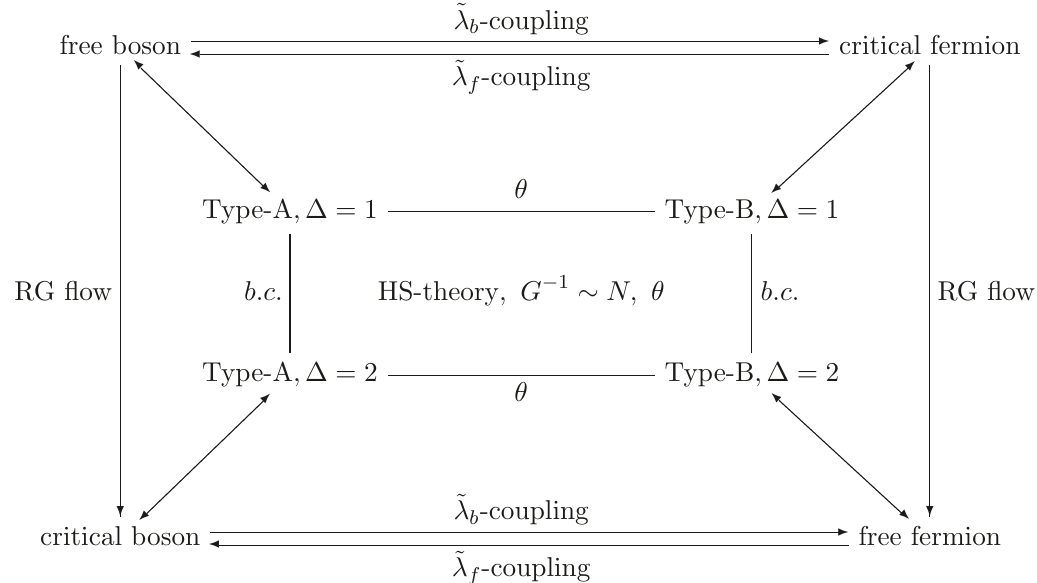
Figure 1 . Schematic depiction of the relationships between various CFTs in three dimensions and higher spin gravity in four dimensions. The latter has two coupling constants, namely ( G, θ ), and ∆ = 1, ∆ = 2 or mixed boundary conditions can be imposed on the scalar